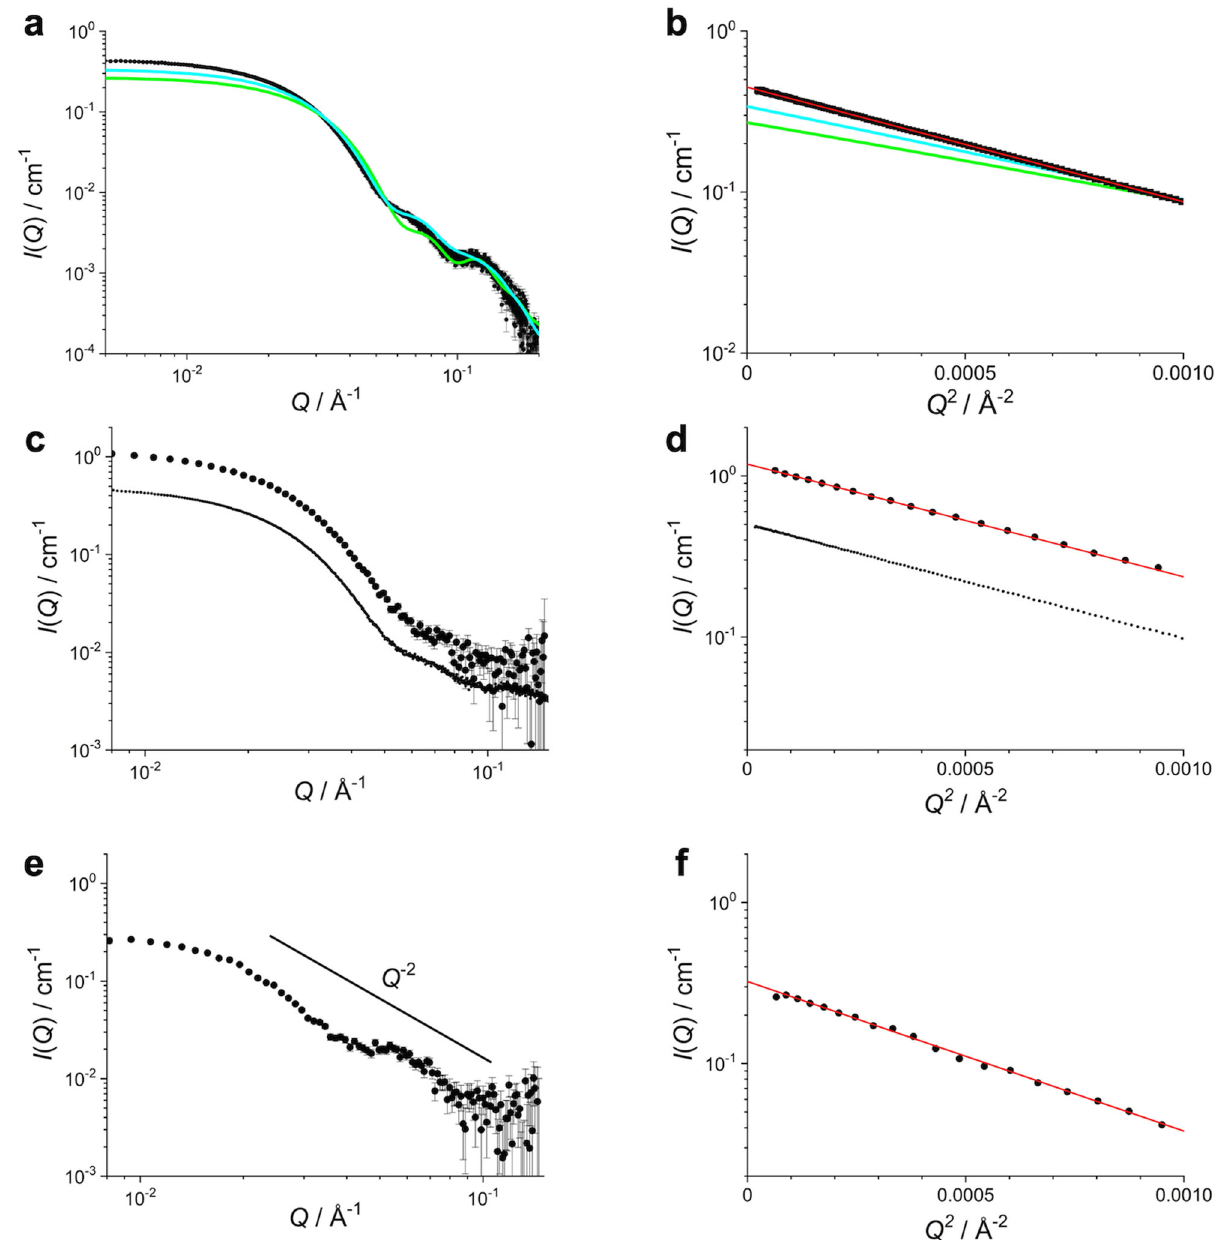
Fig. 1 Scattering pro fi les and their Guinier plots of the A 12 B 6 C 6 complex. a SAXS pro fi les and b their Guinier plots. Black circles show the SEC-SAXS pro fi le and a green line does the SAXS pro fi le calculated from the cryo-EM structure ( χ 2 = 1195) 5 . A cyan line expresses the SAXS pro fi le of the overall A 12 B 6 C 6 model ( χ 2 = 366). In this model, the missing N A domains were supplemented by superimposing six A 2 dimers onto the cryo-EM structure. c SANS pro fi les of hA 12 hB 6 hC 6 complex and d its Guinier plots. Small dots are the SAXS pro fi les and its Guinier plot for the reference. e SANS pro fi les of hA 12 dB 6 dC 6 complex and f its Guinier plots. A straight line in panel e indicates I ( Q ) ~ Q -2 . Red lines in panels b , d , and f show the results of the least-square fi tting for the experimental data with Guinier formula. Error bars represent standard deviation of the